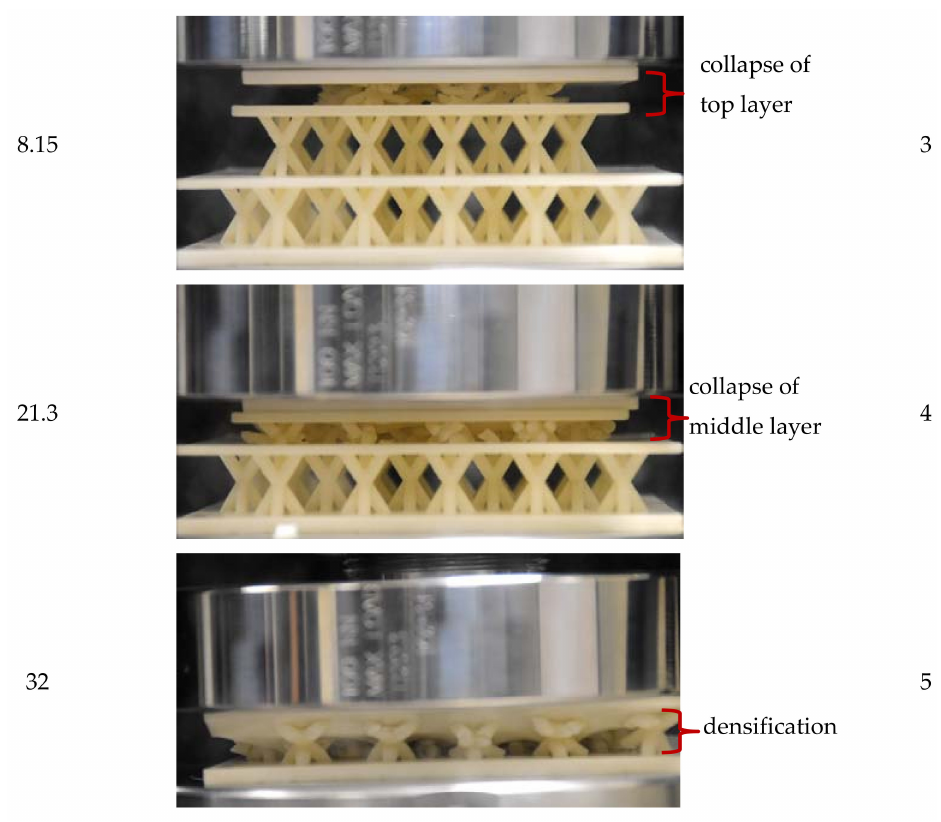
Figure 9. Deformation of a graded density Kagome sample at di ff erent displacement during the compression